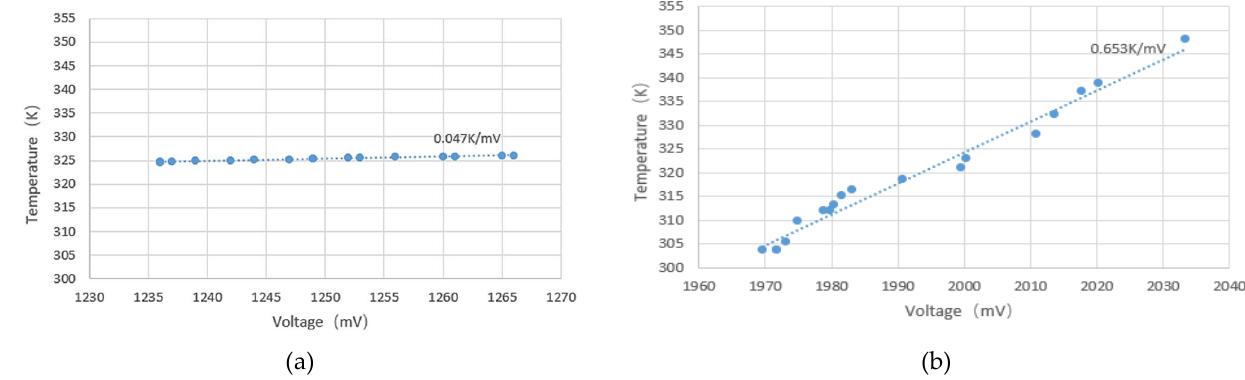
Figure 18. ( a ) Measurement results of the sensitivity of the novel interferometric microwave temperature radiometer; ( b ) measured results of the temperature sensitivity of the full-power microwave temperature radiometer.